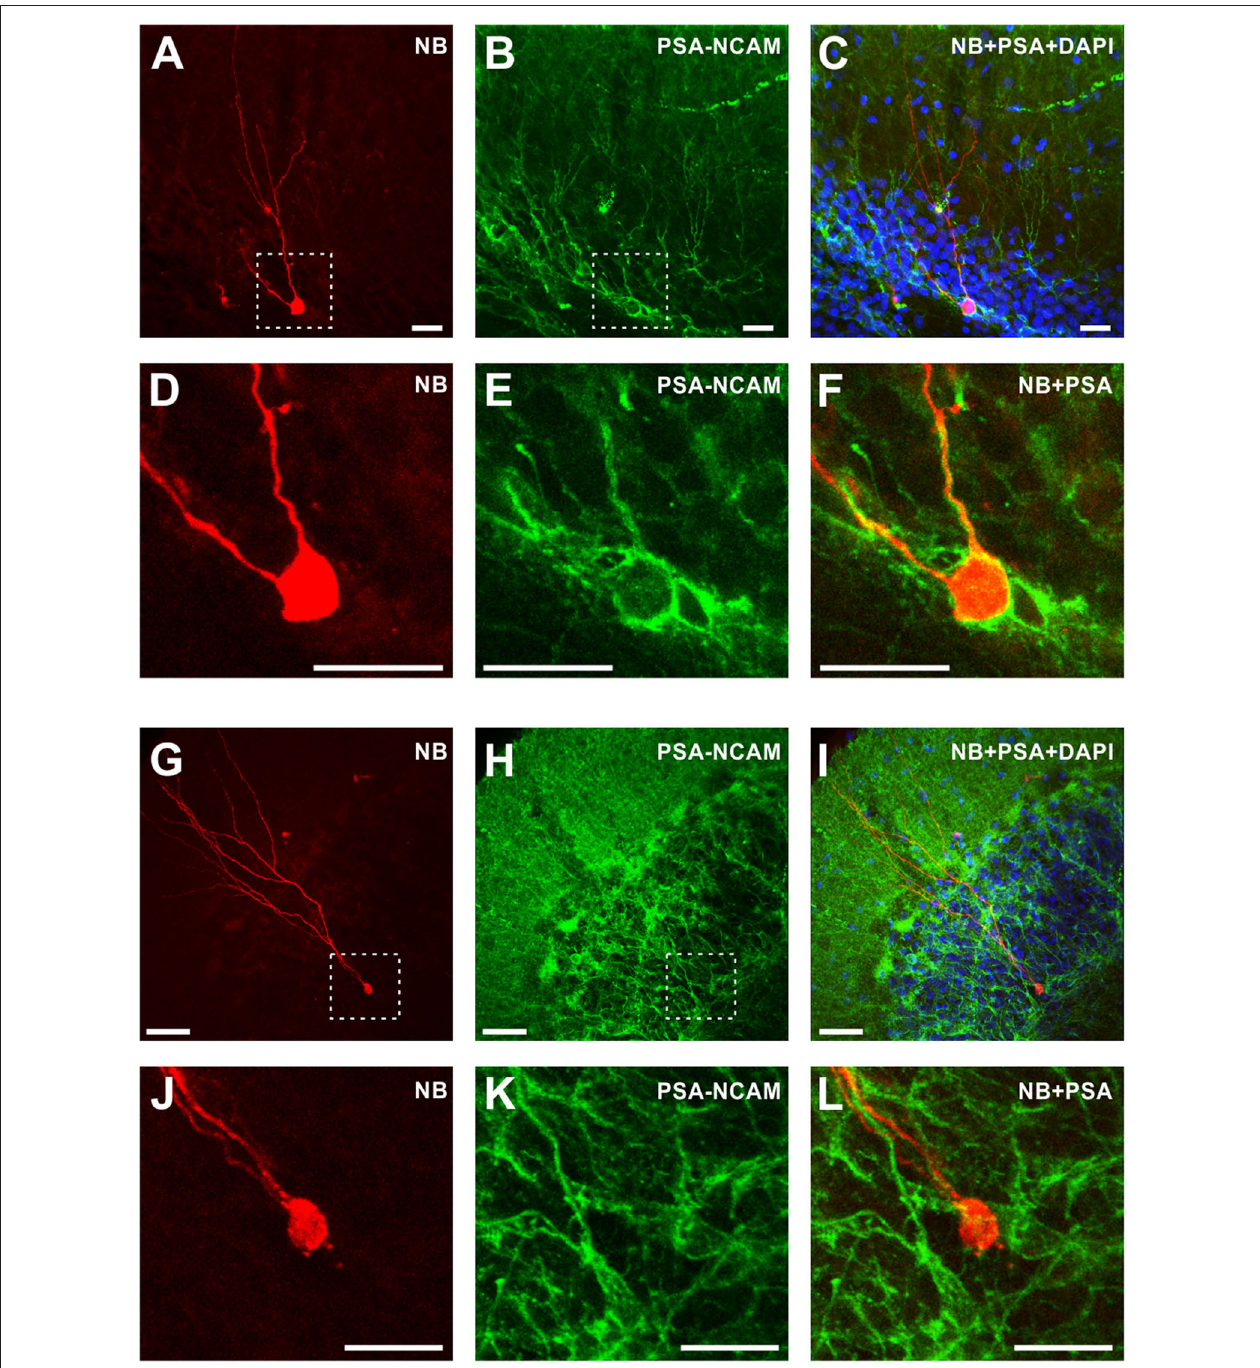
FIGURE 2 | Morphological and immunochemical identification of immature and mature granule cells in the dentate gyrus. Left column (A,D,G,J) Fluorescent images of neurobiotin-labeled immature granule cell with rudimentary dendritic tree (A,D) and a mature granule cell with a characteristic developed dendritic tree (G,J) . (D) and (J) show zoom-in of the regions indicated by dashed lines in (A) and (G) , respectively. Note the difference in scale, 25 µ m in (A) and 50 µ m in (G) . Middle column (B,E,H,K) Immunohistochemical staining with antibodies against PSA-NCAM of the same preparations as in the left column. Right column (C,F,I,L) Superimposition of the images from the left column (morphology), middle column (anti-PSA-NCAM immunostaining), and DAPI staining (C,I) . Note that immature granule cell is PSA-NCAM positive (F) , while mature granule cell is PSA-NCAM negative (L) . Scale bars are 25 µ m in (A–F) and (J–L) ; and 50 µ m in (G–I) .